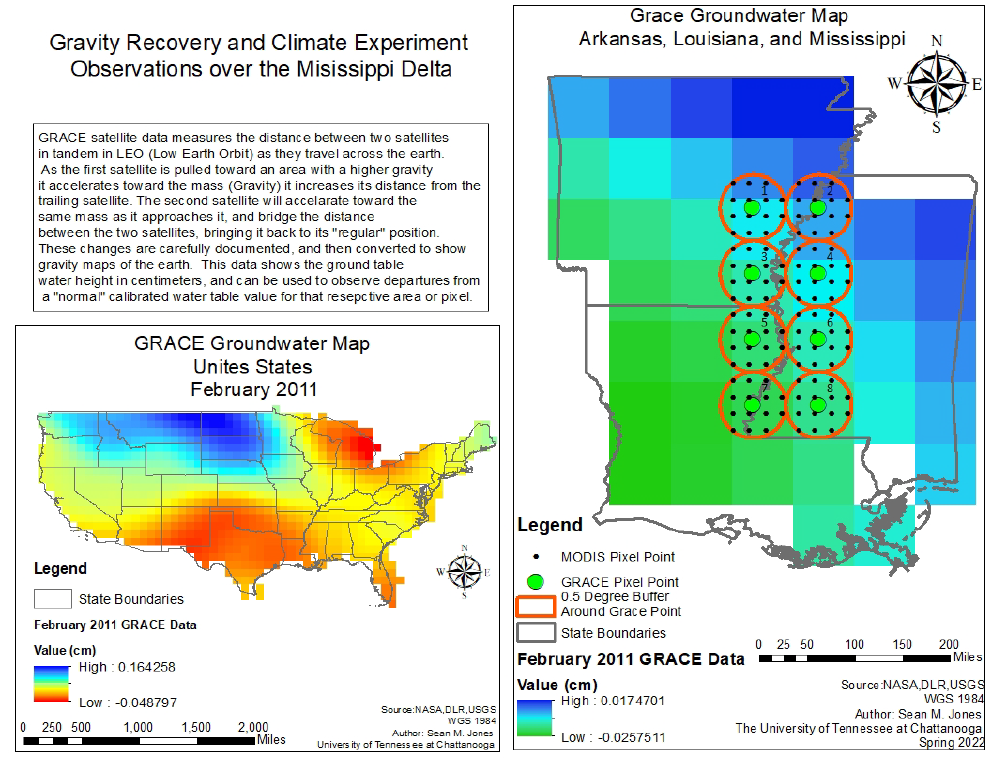
Figure 2. Processed GRACE data for the United States (Left), and Processed GRACE and MODIS data for the Mississippi Delta Physiographic region and surrounding states